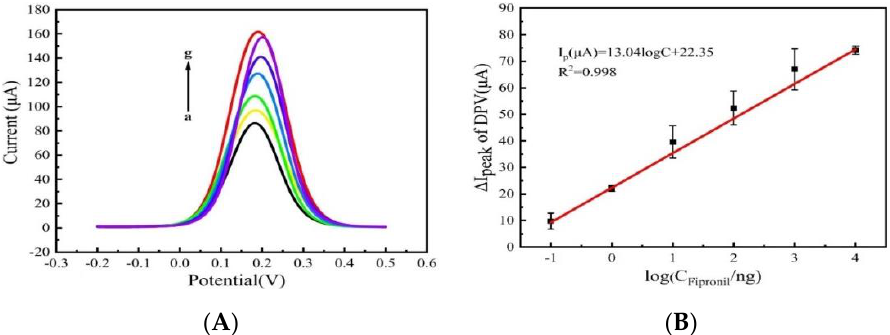
Figure 6. ( A ) DPV responses of the biosensor to fipronil at the concentration of 0 ng/mL, 0.1 ng/mL, 1 ng/mL, 10 ng/mL, 100 ng/mL, 1 μg/mL, 10 μg/mL in K 3 [Fe (CN) 6 ] mixed liquid system. ( B ) The linear relationship between logarithmic value of fipronil concentration and Δ I peak of DPV. Every point in the graph represents the mean of three successive measurements (n = 3) at each concentration. (The length of the error bar, also known as the size of the standard deviation, describes how clustered data points are around the mean).